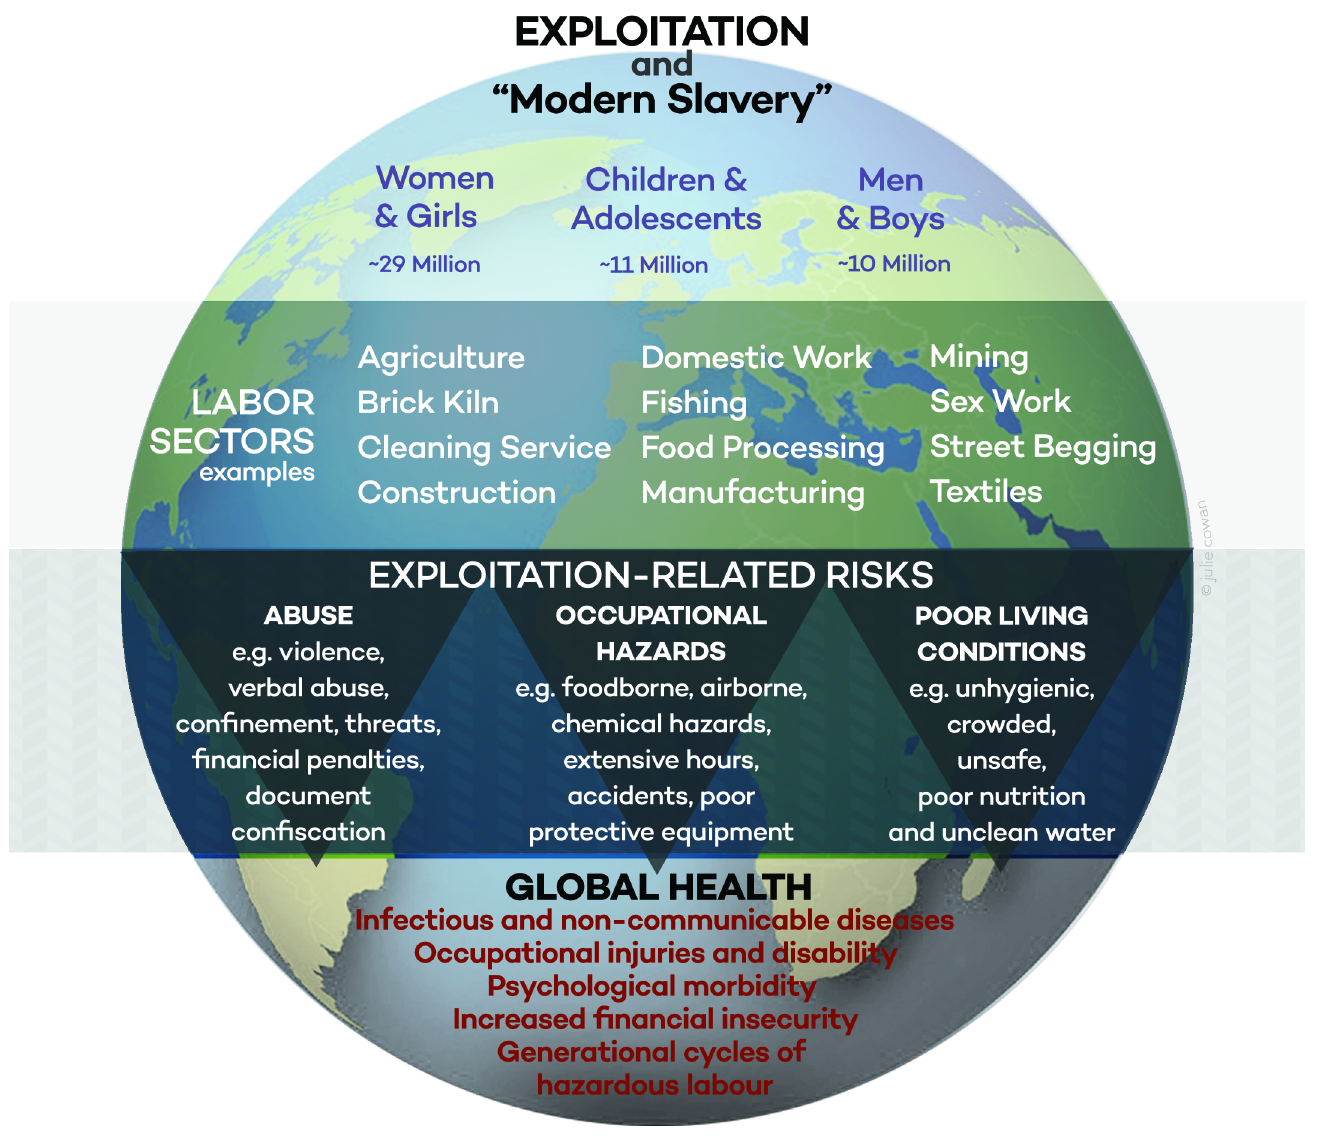
Fig 1. Exploitation, risks, and global